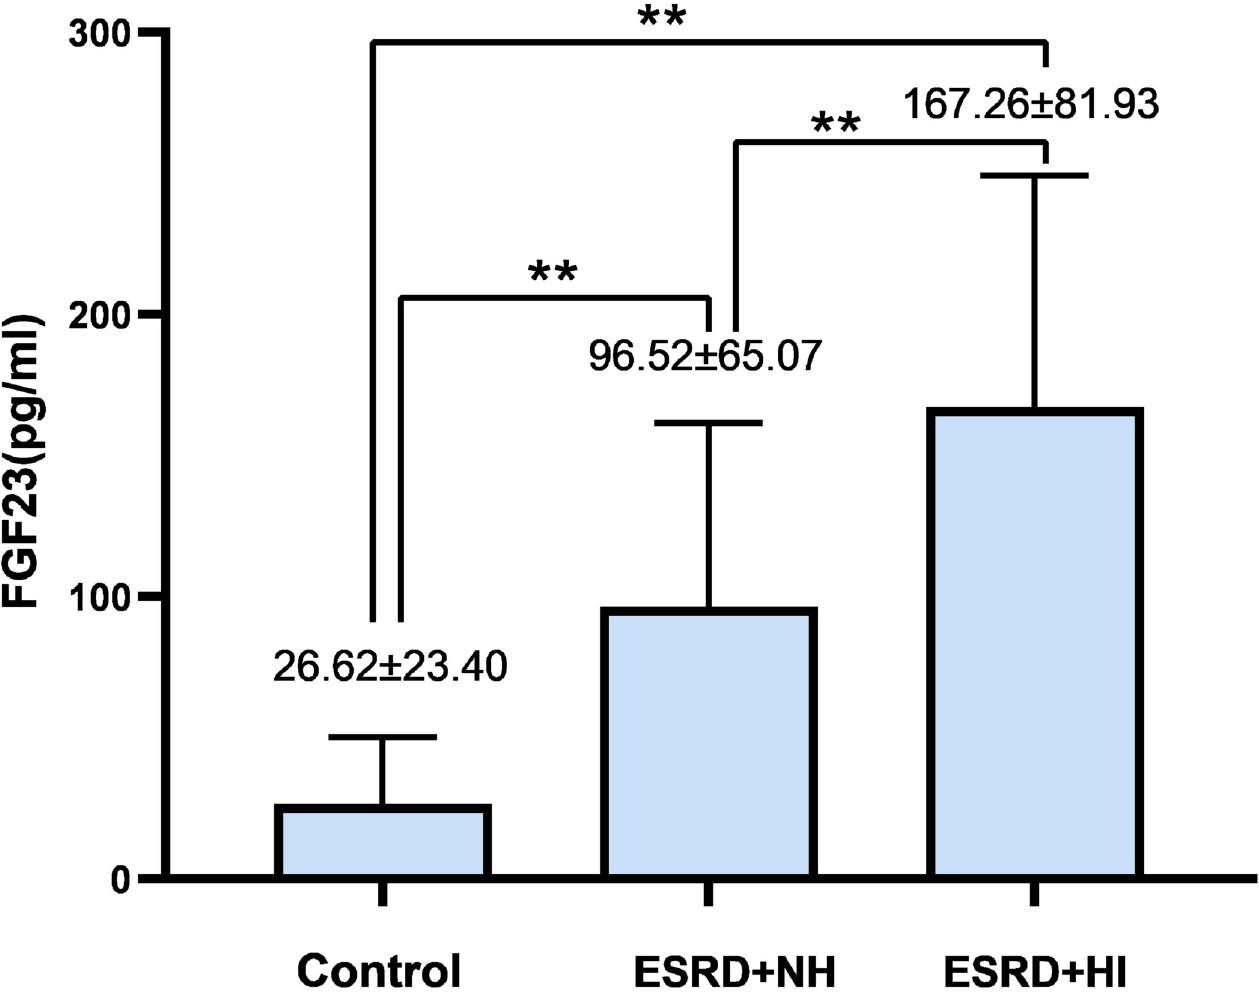
Fig 2. Comparing the FGF23 levels among 3